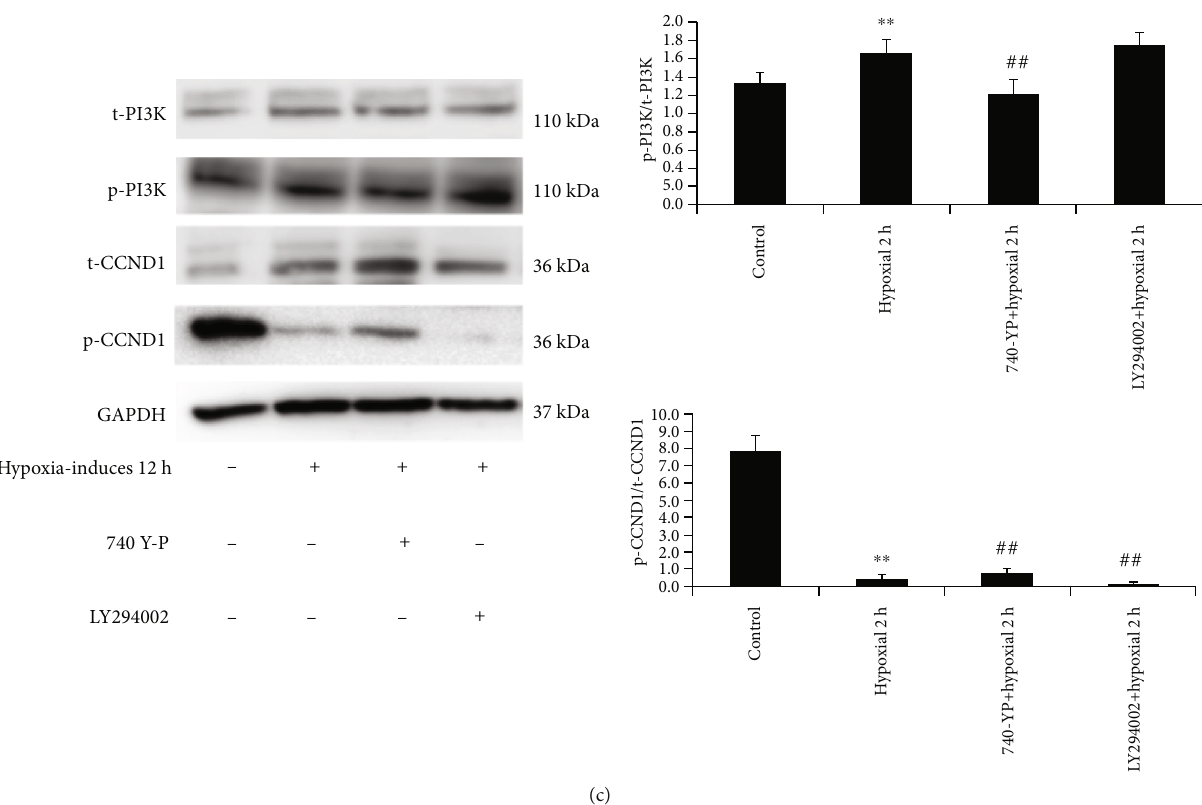
Figure 7: The activation of the PI3K antagonizes the e ff ects of CCND1 on reactive oxygen species (ROS) production and apoptosis in hypoxia-induced senescent hBMSCs. (a) Hypoxia promotes ROS generation, which was reduced by pretreatment with 740 Y-P. Fluorescein isothiocyanate- (FITC-) labeled 2,7-dichlorodihydro fl uorescein acetoacetic acid (DCFH-DA) was used to detect intracellular ROS by fl ow cytometry, and mean fl uorescence intensity (MFI) in cells was calculated. (b) The percentage of apoptotic cells was measured by Annexin V/7-AAD staining. Cells apoptosis was signi fi cantly decreased by 740 Y-P treatment compared to the hypoxia-induced group. (c) Total PI3K (t-PI3K), phospho-PI3K (p-PI3K), total CCND1 (t-CCND1), and phospho-CCND1 (p-CCND1) protein expressions were analyzed by western blotting and quanti fi ed by densitometry. The p-PI3K/t-PI3K ratio in hypoxia-induced senescent cells was signi fi cantly higher than that of the control group; however, the p-CCND1/t-CCND1 ratio was decreased after hypoxia induction. Mean ± SD . ∗∗ p < 0 : 01 vs. the 0 h control group. ## p < 0 : 01 vs. the 12-hour hypoxia-induced group. Western blot bands of p-PI3K (110kDa), t- PI3K (110kDa), p-CCND1 (36 kDa), t-CCND1 (36 kDa), and GAPDH (37 kDa). Experiments were performed in three hBMSC cultures from three di ff erent